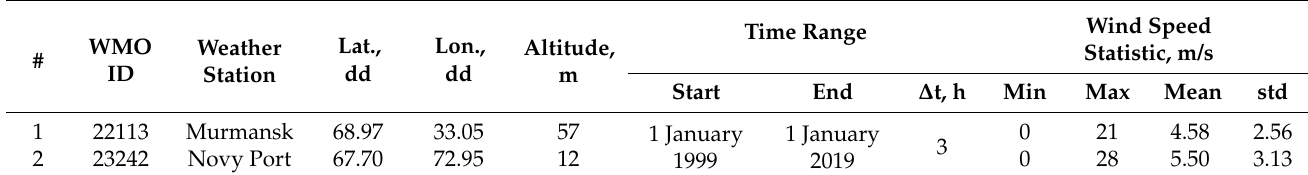
The obtained estimates of the model parameters for the sample data of the selected meteorological stations (Table 1) are calculated by the method described in Section 4 of this article are shown in Figure 4.